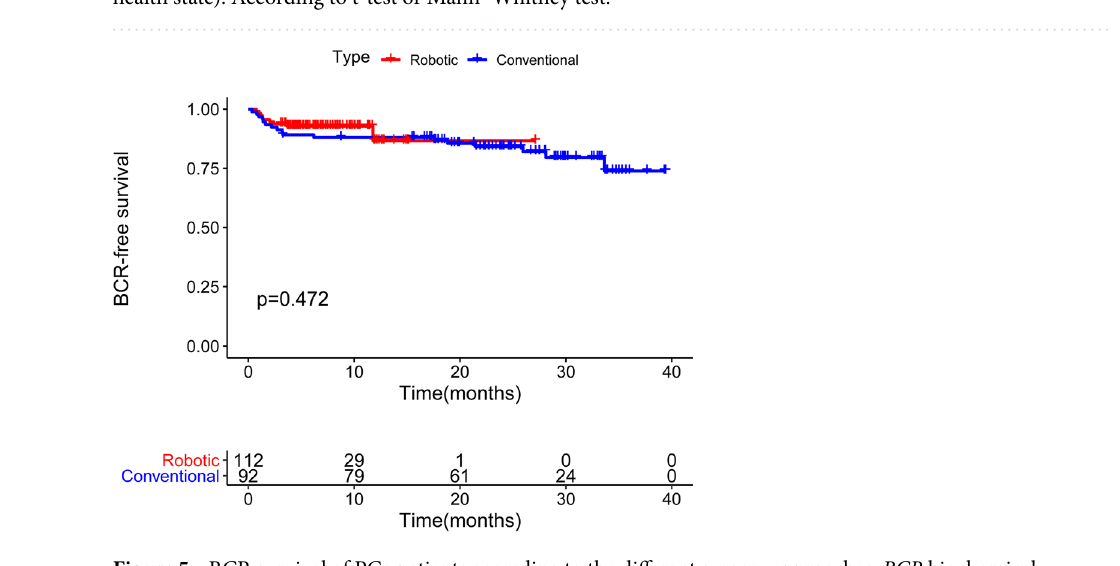
Figure 5. BCR survival of PCa patients according to the different surgery approaches. BCR biochemical recurrence. According to the Kaplan–Meier methodology and compared using log-rank